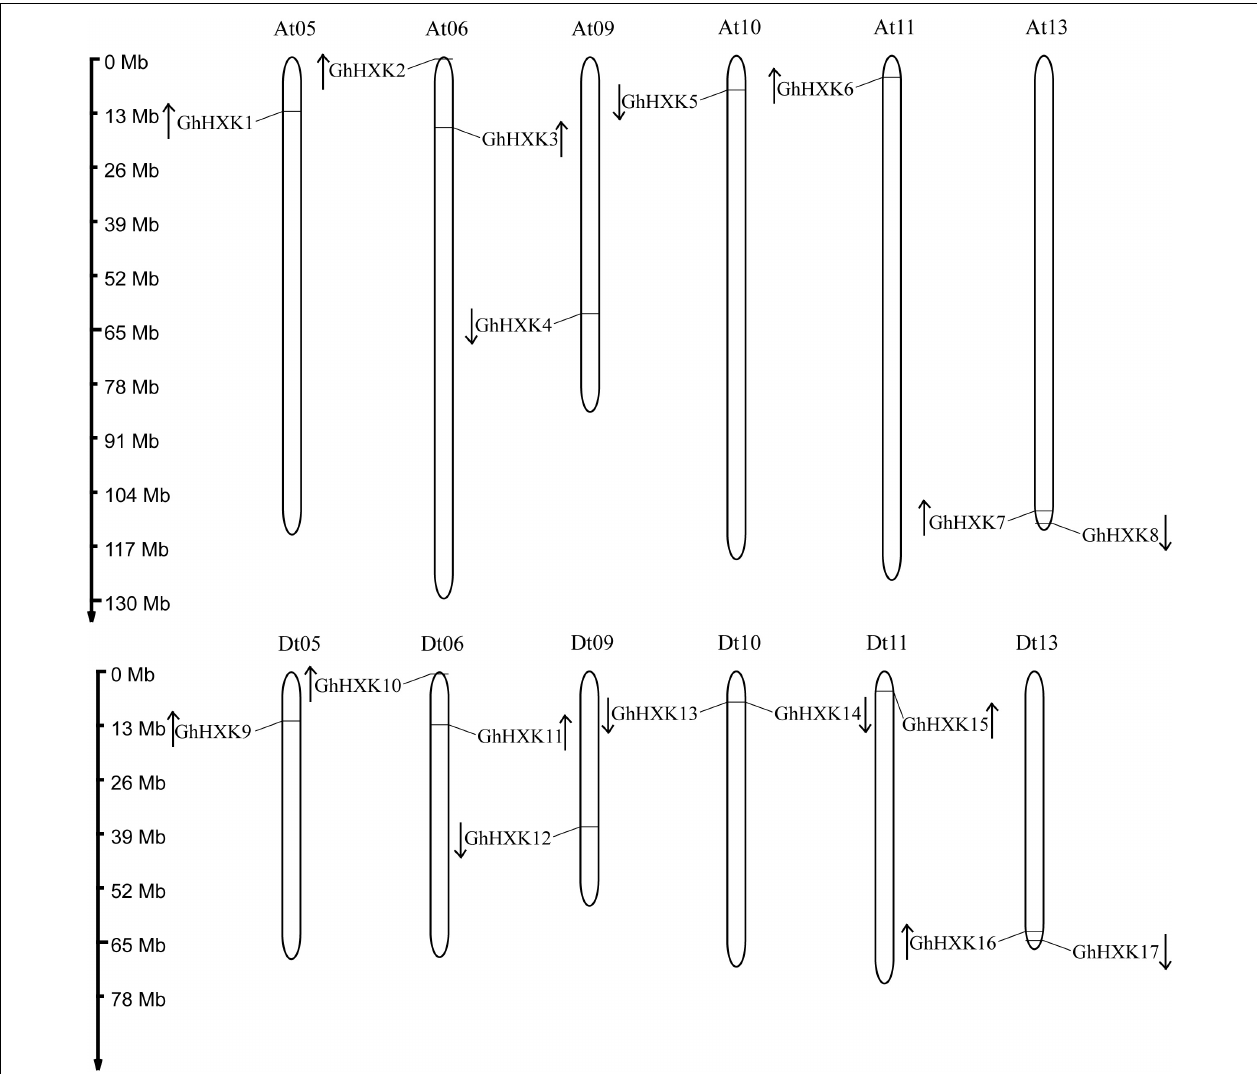
FIGURE 1 | Chromosomal distribution of GhHXKs . The chromosome number is shown above each chromosome. The chromosomal location of each GhHXKs is shown from the top to the bottom of the corresponding chromosome. The scale bars beside the chromosome indicate the length of megabases (Mb). The arrows show the transcription directions of GhHXK